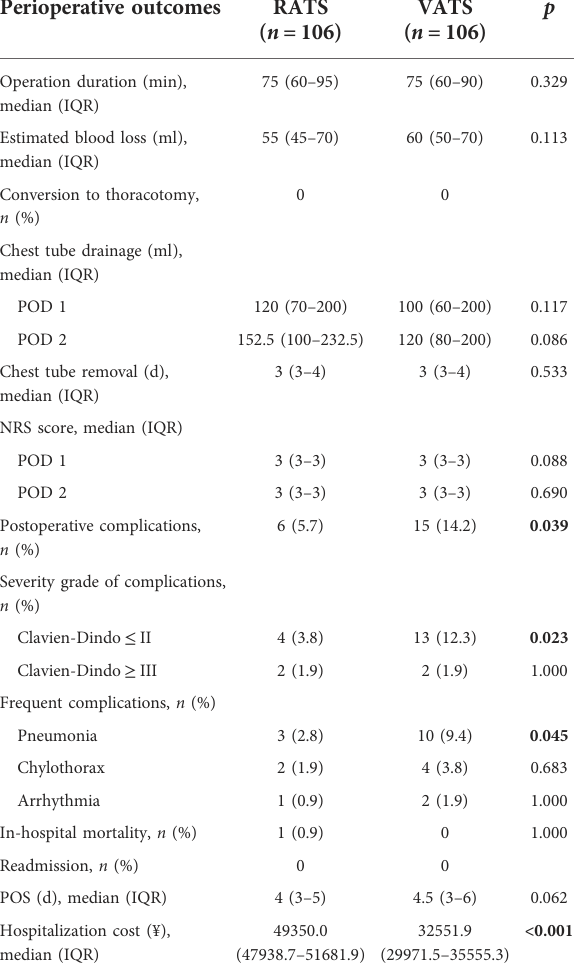
TABLE 2 Perioperative outcomes of VATS and RATS for mediastinal masses. Perioperative outcomes